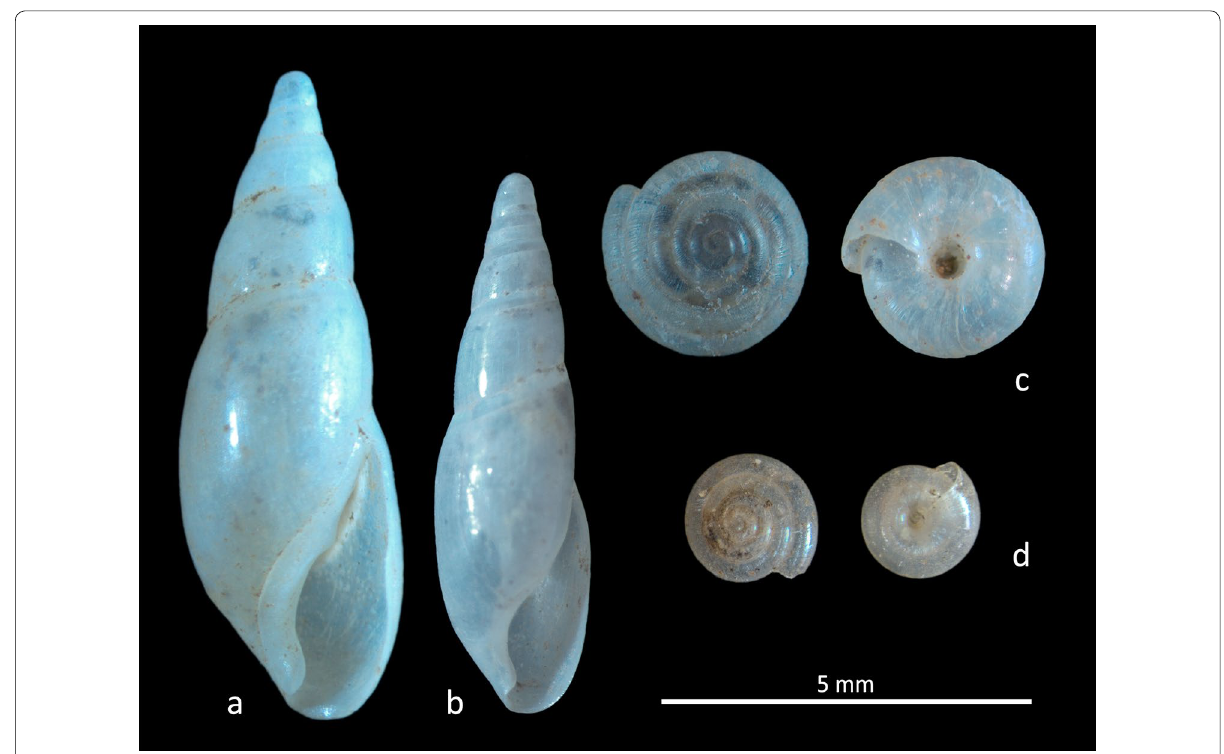
Fig. 4 Shells of a Cecilioides michoniana ; b Cecilioides tumulorum ; c Vitrea riedeliana ; d Vitrea